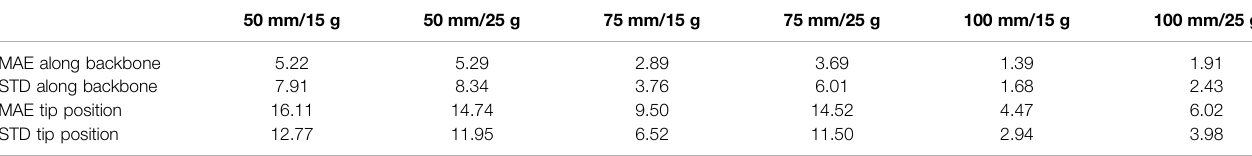
TABLE 5 | Results of multi-tube experiment. All deviations are measured in mm. Column labels describe length of outer tube/weight at tip. 50 mm/15